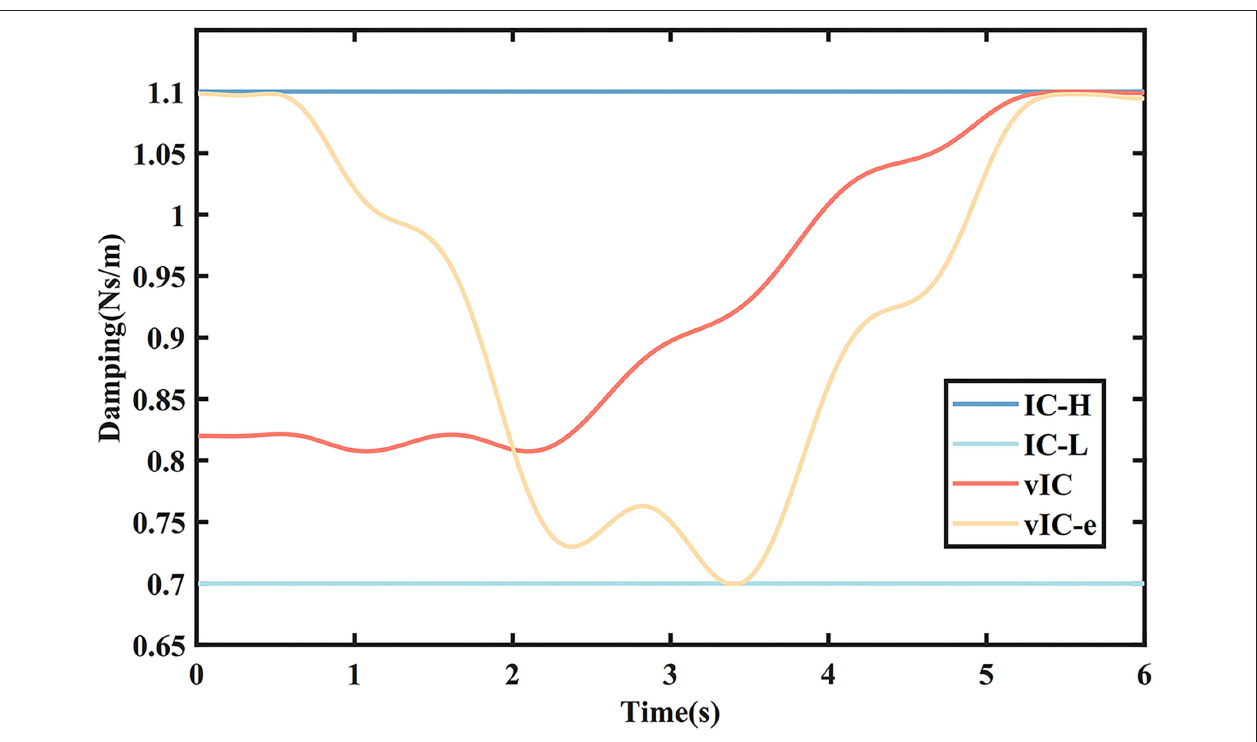
FIGURE 5 | The damping values of different control algorithms in the main motion axis.